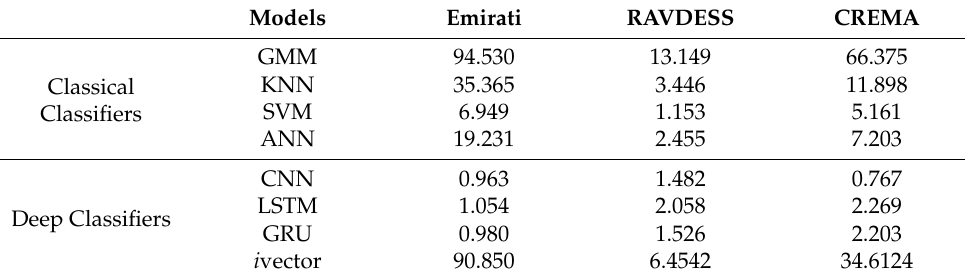
Table 9. Testing time (in seconds) of classical, i vector, and deep models.